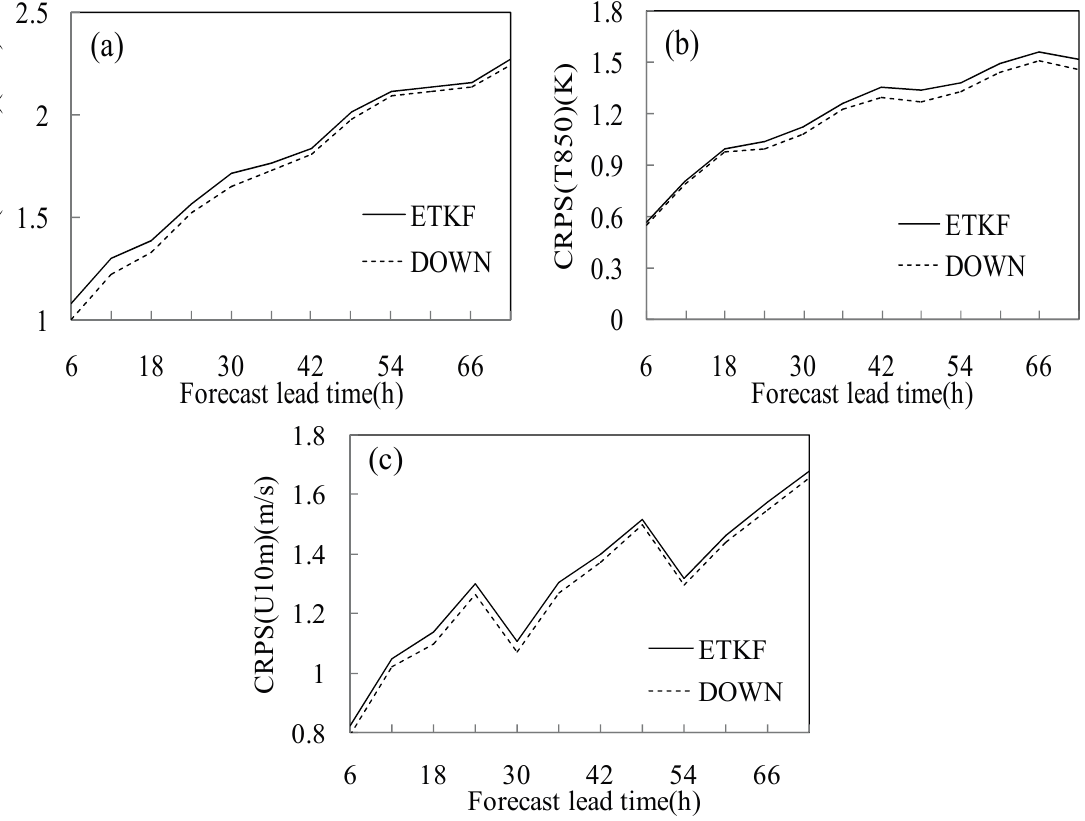
Figure 7. CRPS as a function of forecast lead time, for ETKF and DOWN, respectively. ( a ) 500 hPa wind speed; ( b ) 850 hPa temperature; ( c )10 m U